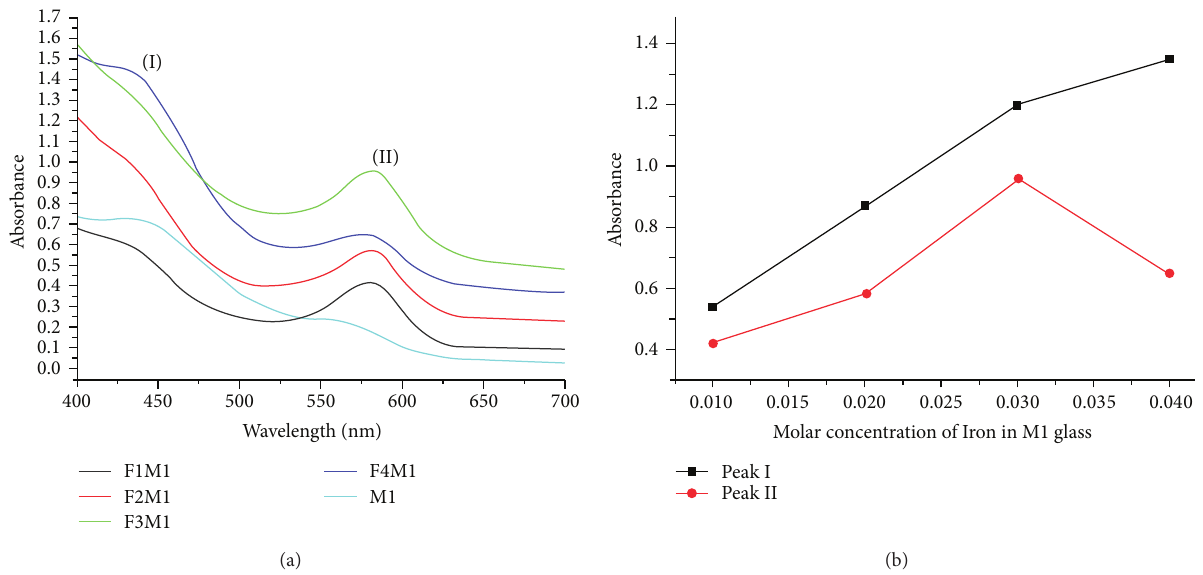
Figure 3: (a) Absorption spectra of Fe-MG SiO 2 glasses (F1M1, F2M1, F3M1, and F4M1) and M1 glass. (b) Variation of absorbance with molar concentration of Fe-I in F 𝑥 M1 glasses ( 𝑥 = 1 – 4 ).